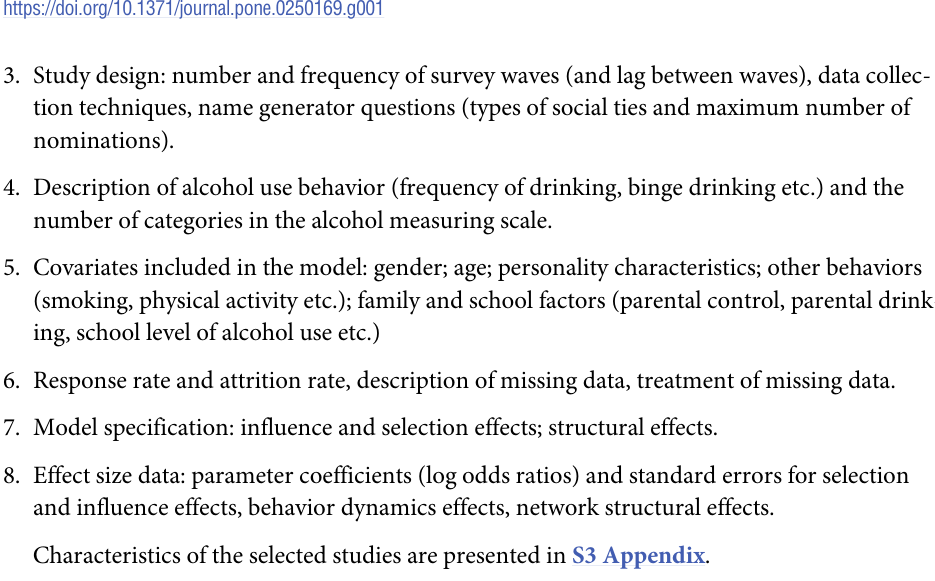
Fig 1. Flowchart diagram for articles screening and